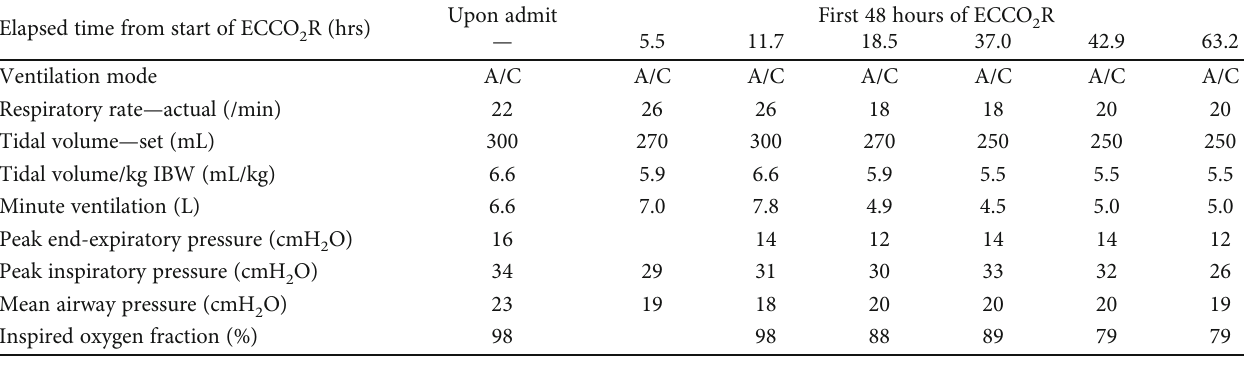
Table 2: Mechanical ventilation parameters prior to and during the fi rst 48 hours of Hemolung therapy. Upon admit R (hrs) Elapsed time from start of ECCO 2